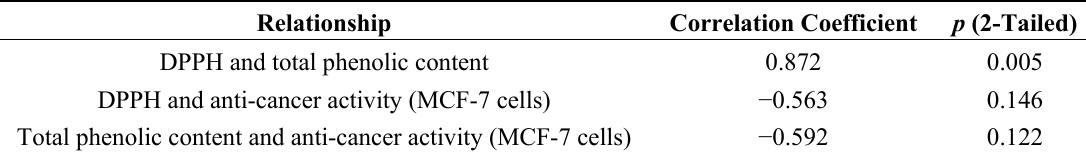
Table 5. Bivariate correlation of anti-cancer activities, antioxidant activity, and total phenolic content of cocoa plant part extracts.